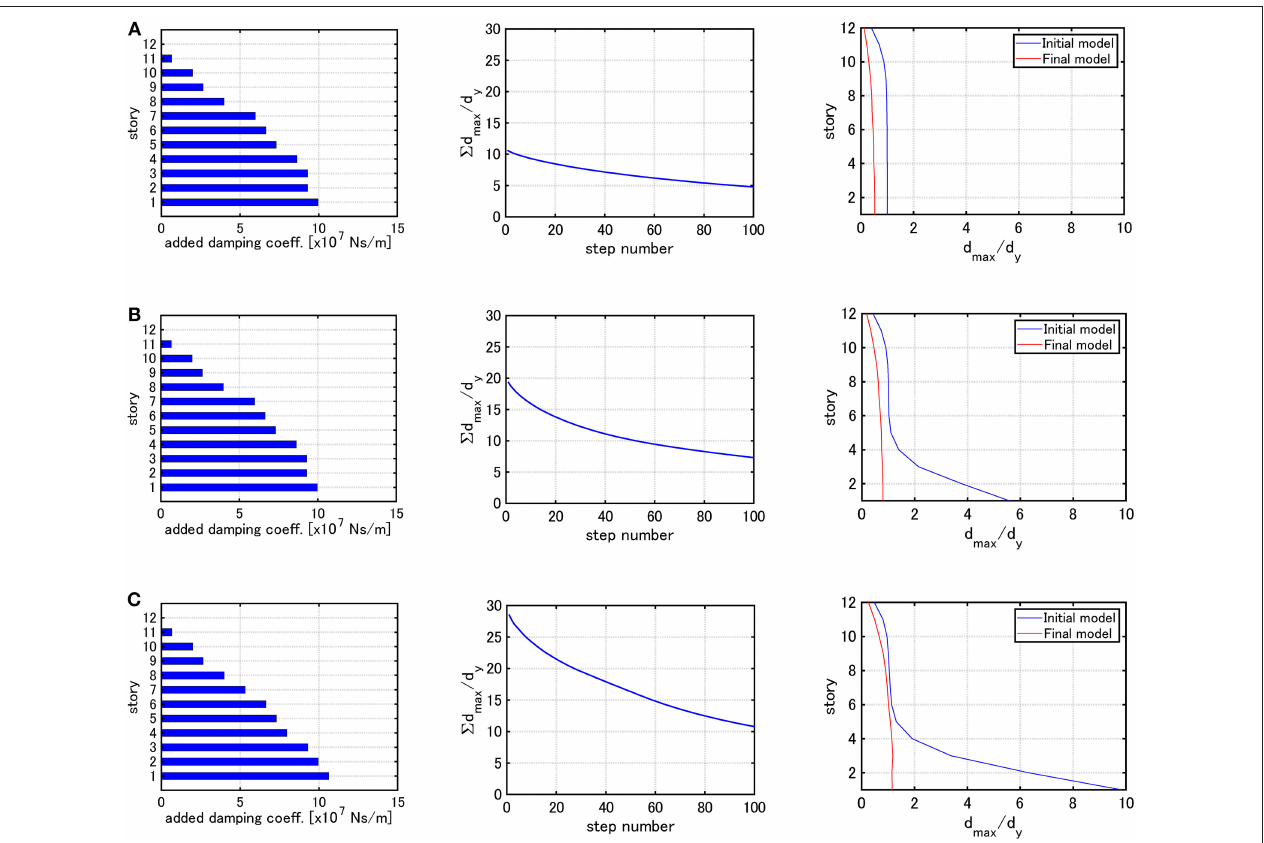
FIGURE 9 | Distribution of added damping coefficients, P d max , i / d y with respect to step number and the distribution of d max , i / d y under the critical double impulse for Model 1 (Problem 2): (A) Elastic limit, (B) V = 0.84[m/s], (C) V =